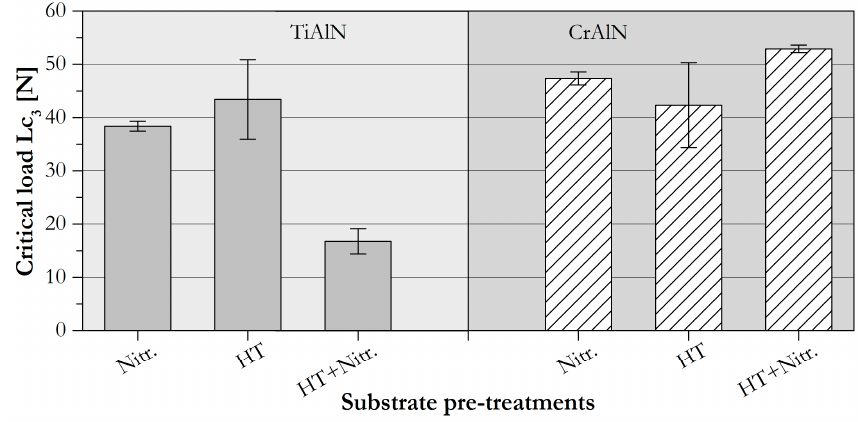
Figure 8. Critical load Lc 3 of the TiAlN and CrAlN coatings deposited on the different substrates.